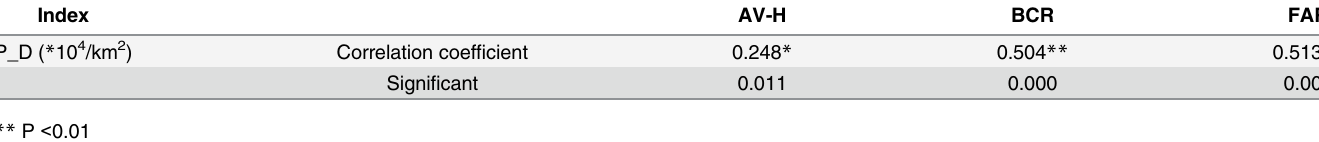
Table 3. Correlation between population and architectural